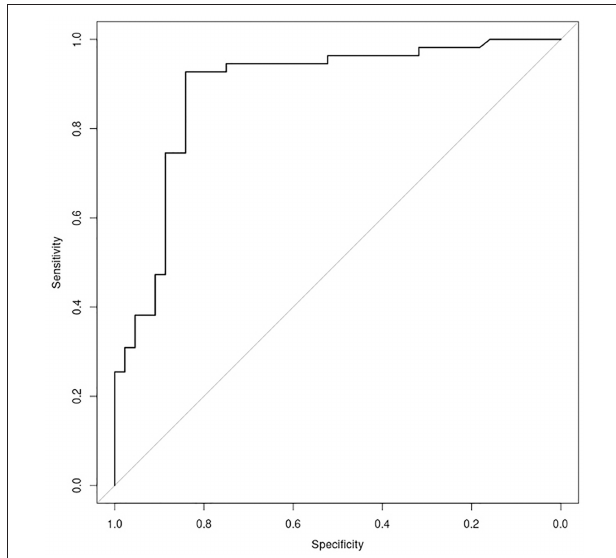
FIGURE 5 | Plot of ROC curve for the “psychological support” model (AUC = 0.8866), showing possibility to identify patients who need intensive support with regards to the total score, achieved putting into the model the value of relevant items of M.A.P.-RT.